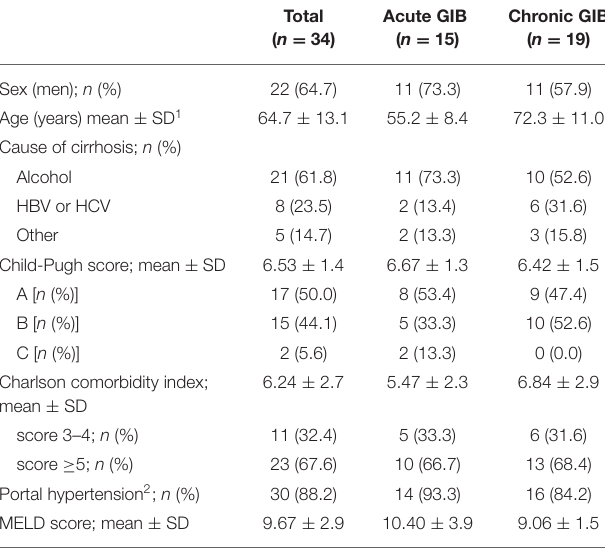
TABLE 1 | Patient baseline clinical characteristics ( n = 34).